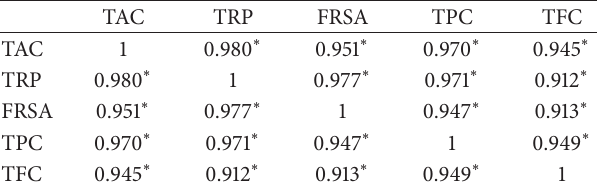
Table 3: Correlation matrix among antioxidant properties and polyphenol and flavonoid contents of the polyherbal formulation “ImmuPlus.” TAC TRP FRSA TPC